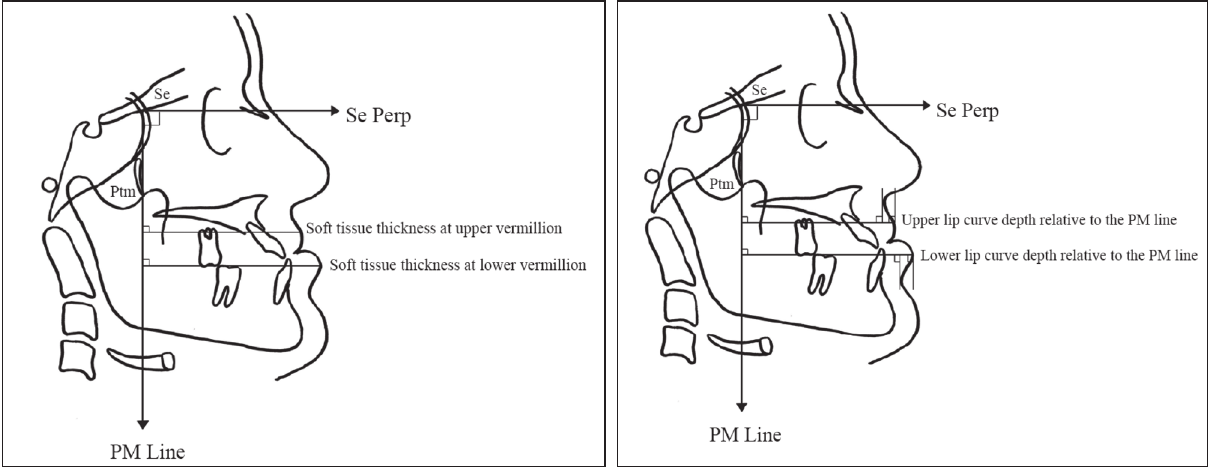
Figure 1. Pterygomaxillary line through points Se and Ptm, constructed horizontal line perpendicular to the PM line through Se; soft tissue thickness measurement of upper and lower lips.